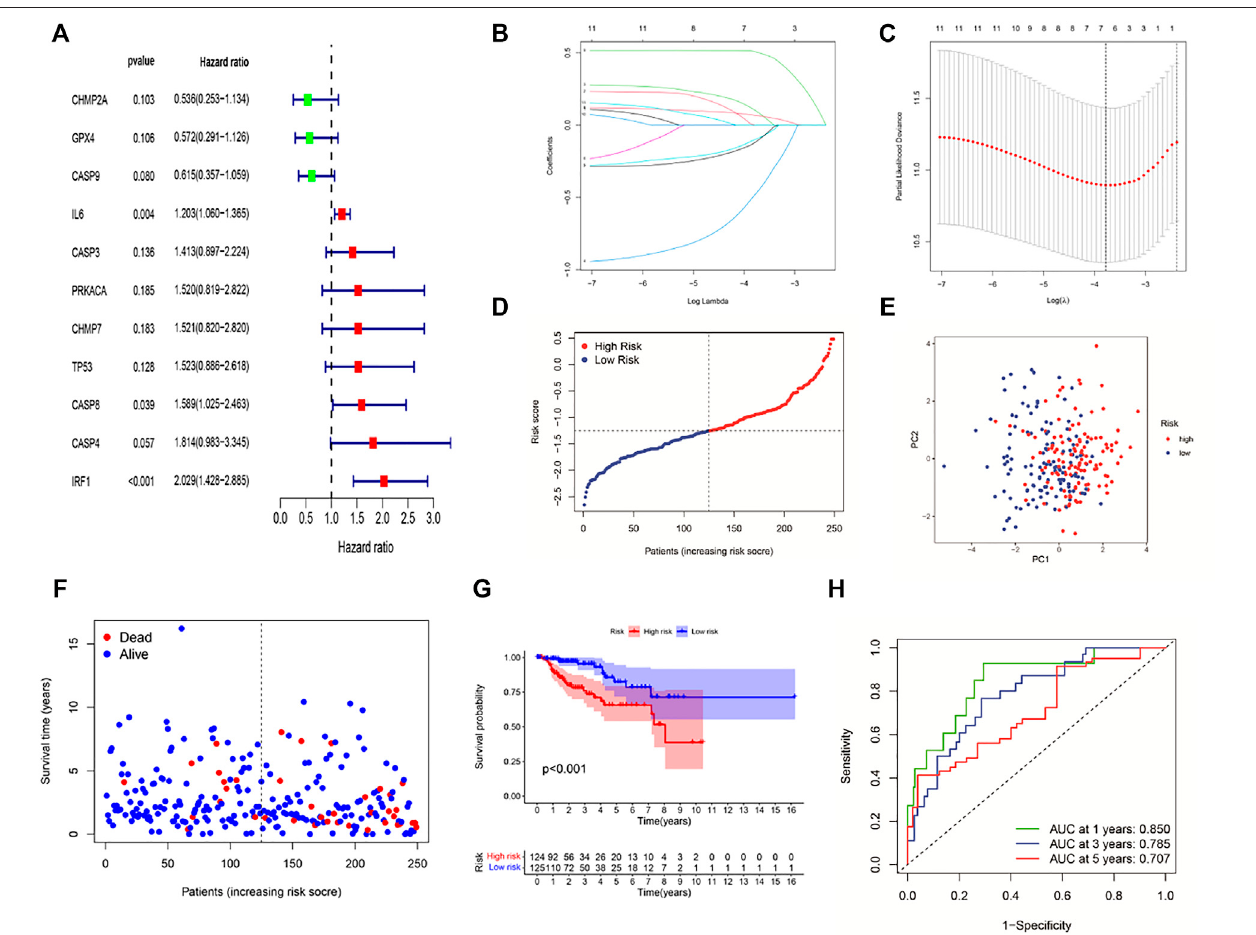
FIGURE3 | Construction ofasix-gene prognostic signature in KIRP patients. (A) Univariate coxregressionanalysisof11 PRGs( p < 0.2). (B,C) LASSO regression of 11 PRGs and the tuning parameter ( λ ) selection cross-validation curve. (D) Distribution of risk scores for KIRP patients. (E) PCA plot based on the risk score. (F) Distribution of patient survival status according to the high-risk group and the low-risk group. (G) Kaplan – Meier curves for OS in the low- and high-risk groups. (H) ROC curves to evaluate the predictive ef fi ciency of the risk model.